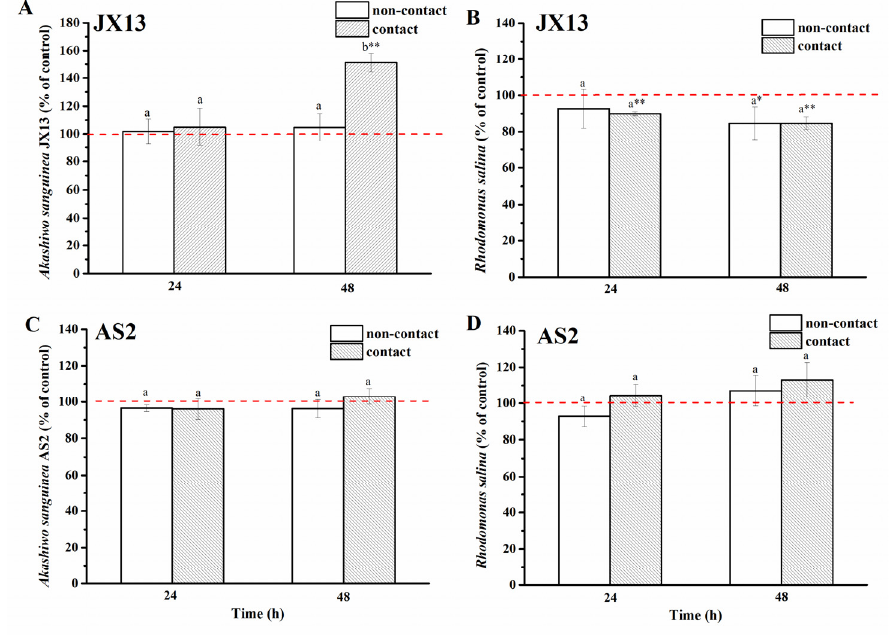
Figure 5. Contact and non-contact coculture of Akashiwo sanguinea (JX13, AS2) and Rhodomonas salina CCMP1319. ( A , B ): A. sanguinea JX13 co-cultured with R. salina ; ( C , D ): A. sanguinea AS2 co-cultured with R. salina . Initial cell densities of A. sanguinea and R. salina were 3,000 cells mL − 1 and 1,000 cells mL − 1 , respectively. Results are expressed in triplicate ± standard deviation (SD). Different lower-case letters (a, b) indicate significant differences ( p < 0.05) between treatments at the same co-culture times; * and ** indicate significant differences ( p < 0.05 and p < 0.01, respectively) between treatment and control.